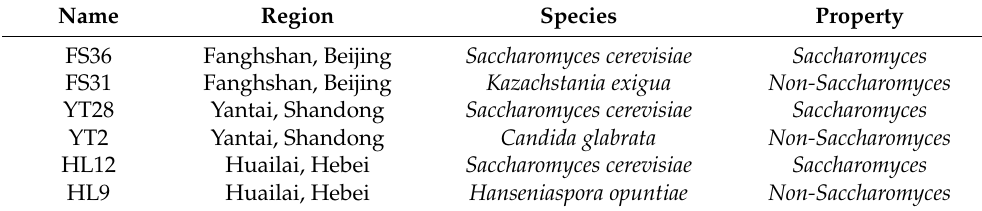
Table 1. The information of yeast